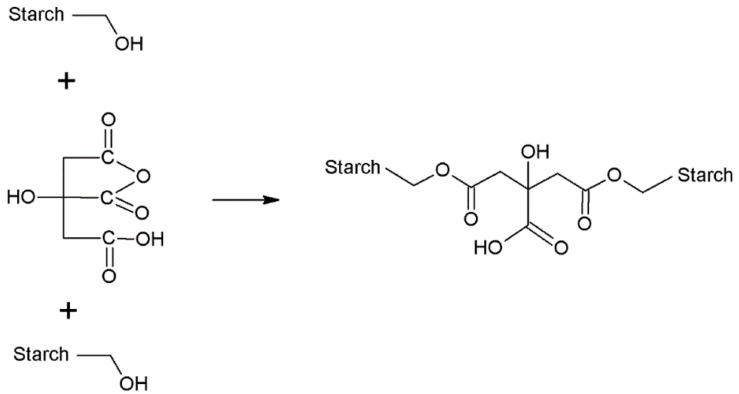
Figure 10. Chemical cross-linking reaction of starch using citric acid